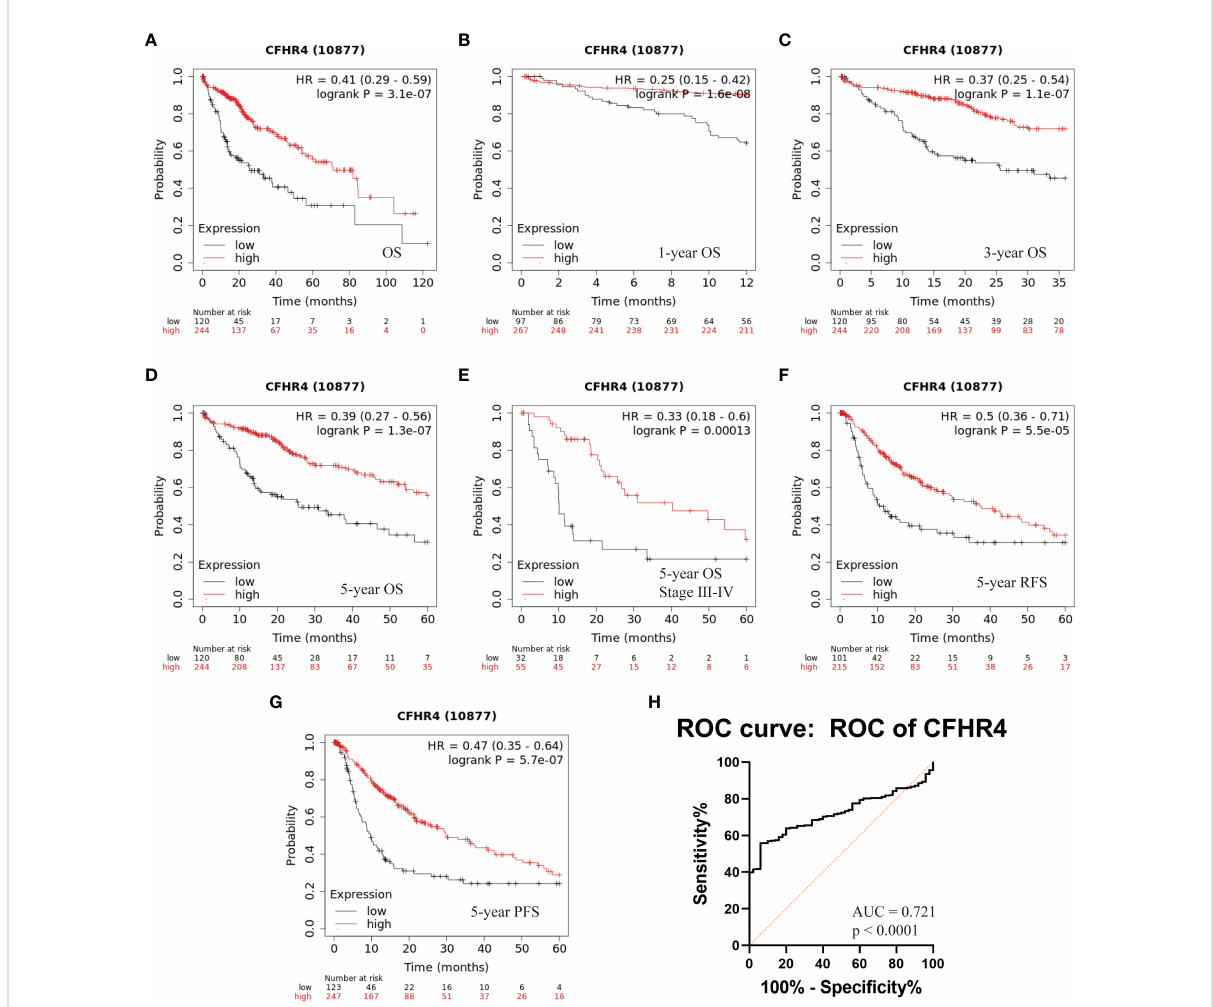
FIGURE 6 Kaplan-Meier survival analysis of HCC patients with respect to CFHR4 expression. (A – D) The association between CFHR4 expression and Overall survival (OS). (E) Multivariate analyses of TNM stage and CFHR4 expression with the 5-year OS. (F, G) The associations between CFHR4 expression and 5-year relapse free survival (RFS), as well as CFHR4 and 5-year progression free survival (PFS). (H) The assessment of receiver operating characteristic (ROC) curve for CFHR4